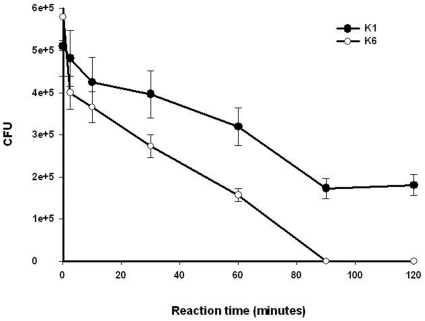
The rate at which neutrophils from 11 healthy volunteers killed serotypes K1 and K6 K. pneumoniae.The percentage of killing is expressed as the mean ± SD and calculated as the total number of bacteria killed divided by the number of viable bacteria in the initial inoculum. K1 vs. K6: p<0.01 (n = 3 for each).